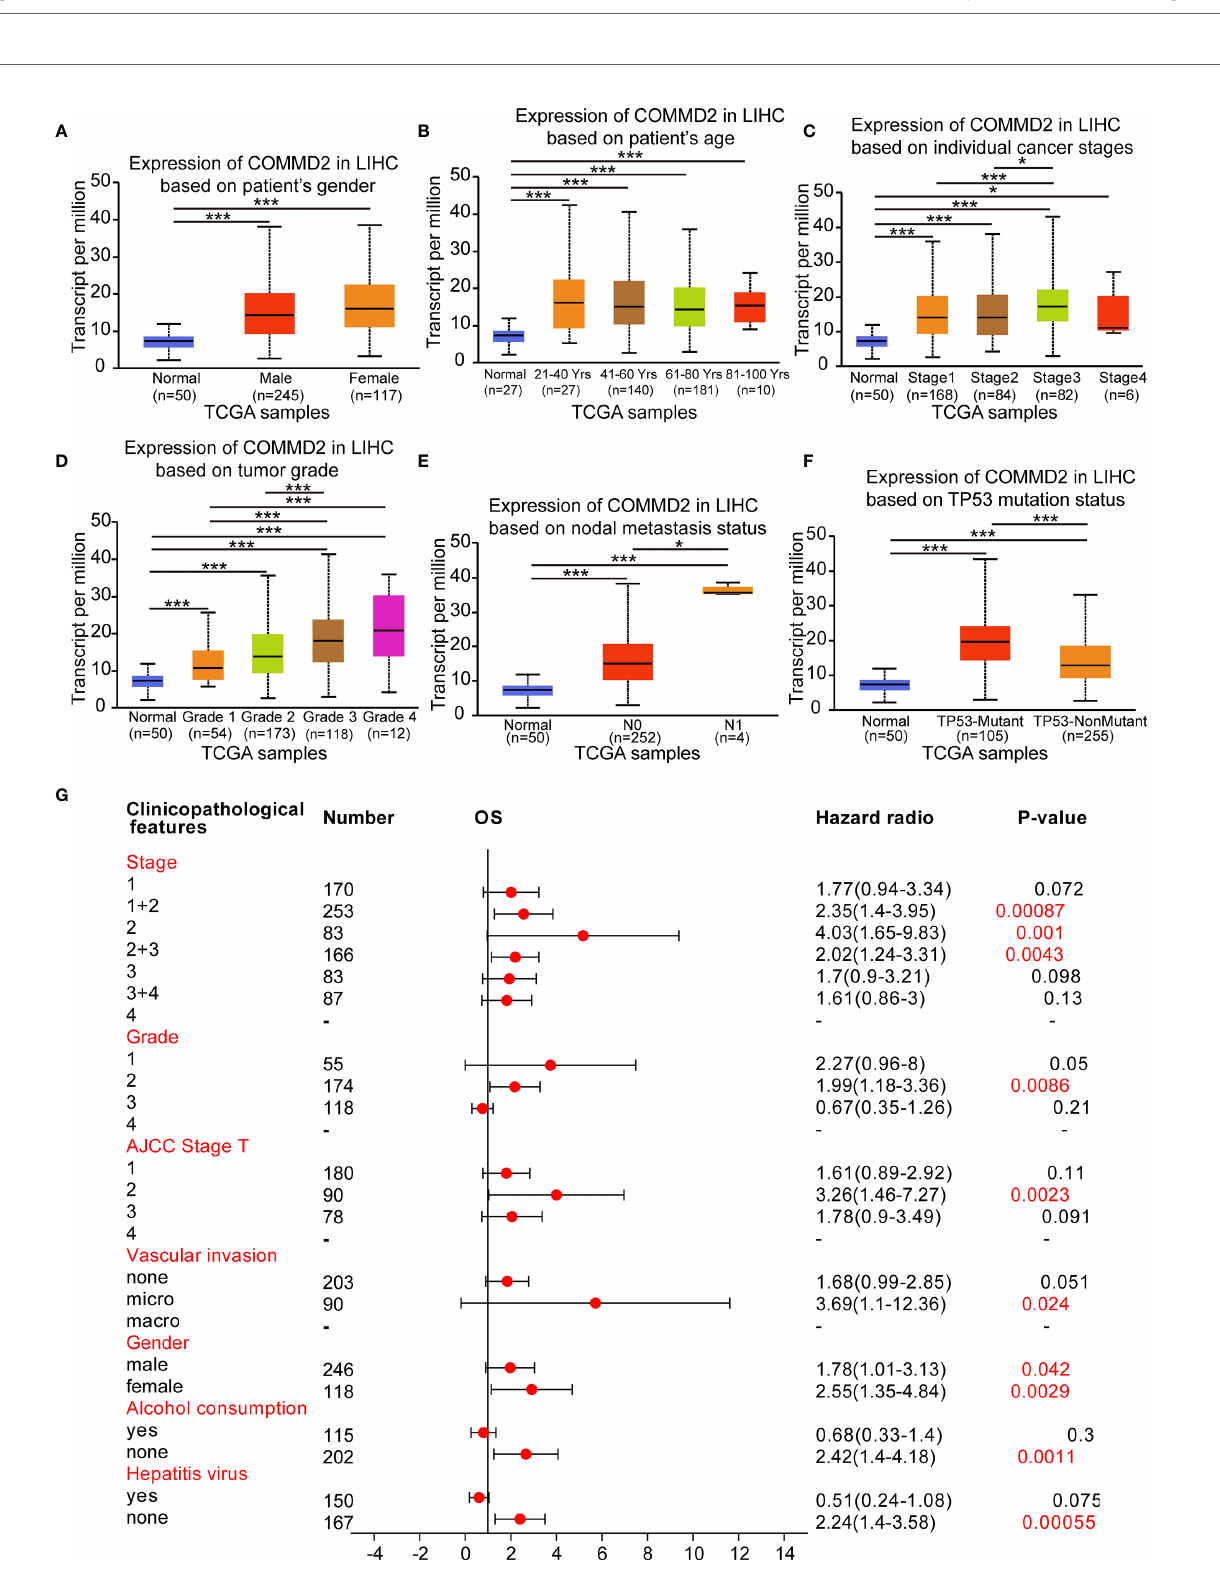
FIGURE 3 | Association of COMMD2 expression with the clinicopathological features of LIHC patients. (A – F) Boxplot showing COMMD2 expression in normal individuals and LIHC patients based on clinicopathological features using the UALCAN database. Patient sex (A) , patient age (B) , cancer stage (C) , tumor grade (D) , nodal metastasis status (E) and TP53 mutation status parameters were analyzed (F) . (G) Forest plot showing the association between COMMD2 expression and clinicopathological parameters of LIHC patients. *p < 0.05; ***p <